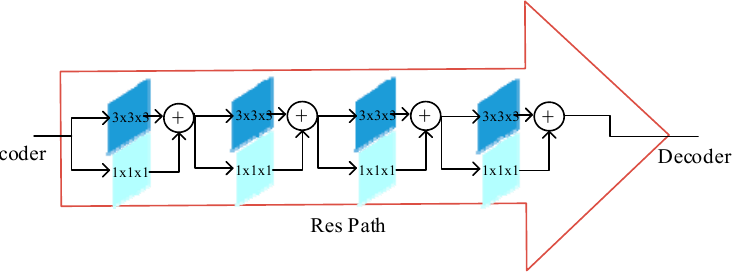
Figure 3. Res path frame diagram (Reprinted with permission from Ref. [29]. Copyright 2020 Else-